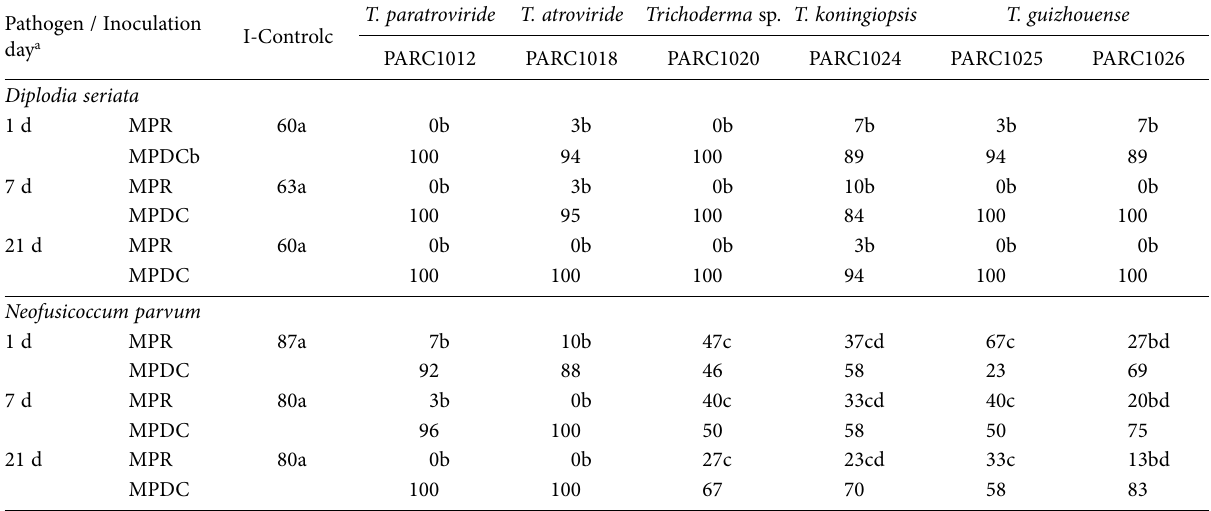
Table 2. Detached cane assay results under controlled conditions. Values represent the mean percent recovery (MPR) of Diplodia seriata (PARC91) and Neofusicoccum parvum (PARC15) from pruning wounds treated with selected Trichoderma isolates from southern Italy and inoculated 1, 7 or 21 d after treatment. Values in each row followed by same letters are not statistically different (P = 0.05), Tukey-Kramer multiple comparison